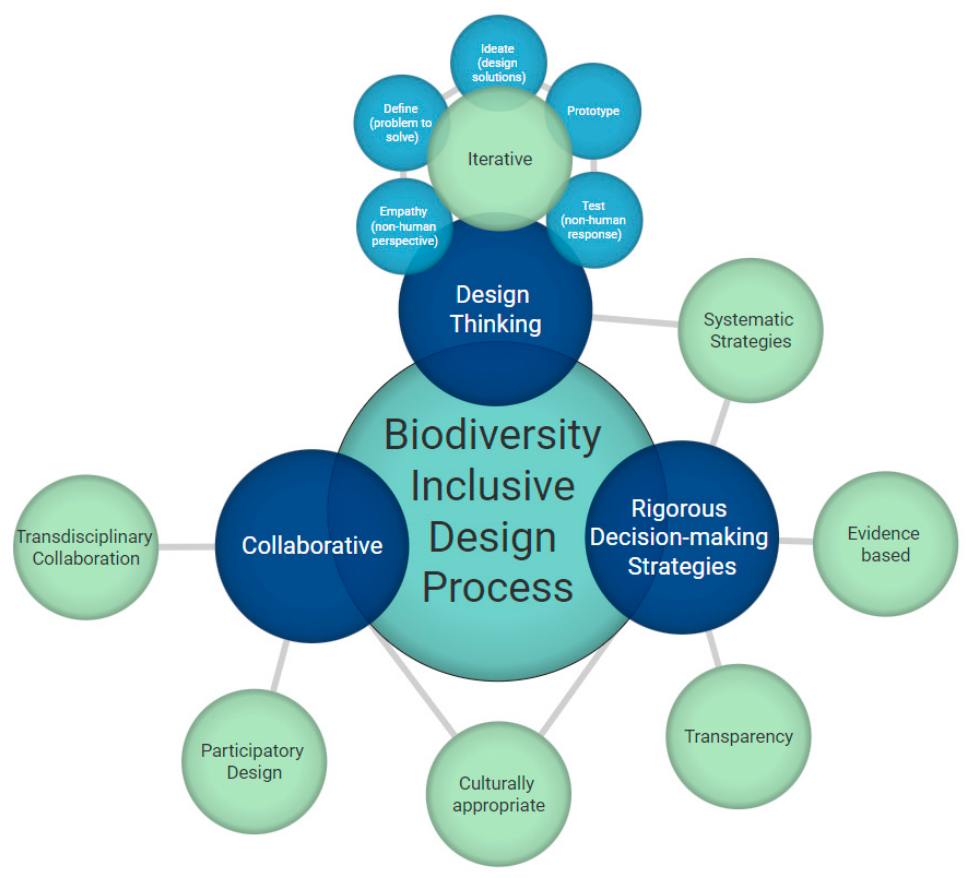
Figure 3. Thematic analysis of BID. The size of each bubble stands for the level of thematic categorisation. At the centre, the overarching topic of this research is the BID process. The next size down, in dark blue colour, are BID’s three core components: collaborative process, collaborative thinking, and decision-making. The next size down, in light green colour, are the seven themes found: transdisciplinary collaboration, participatory design, culturally appropriate, iterative, systematic strategies [do design], evidence-based [design decisions] and transparency. The lines denote the association between the themes and components of BID. Lastly, the smallest bubbles, in light blue colour, correspond to the five phases of the iterative design cycle. This figure was created using 7vortex.